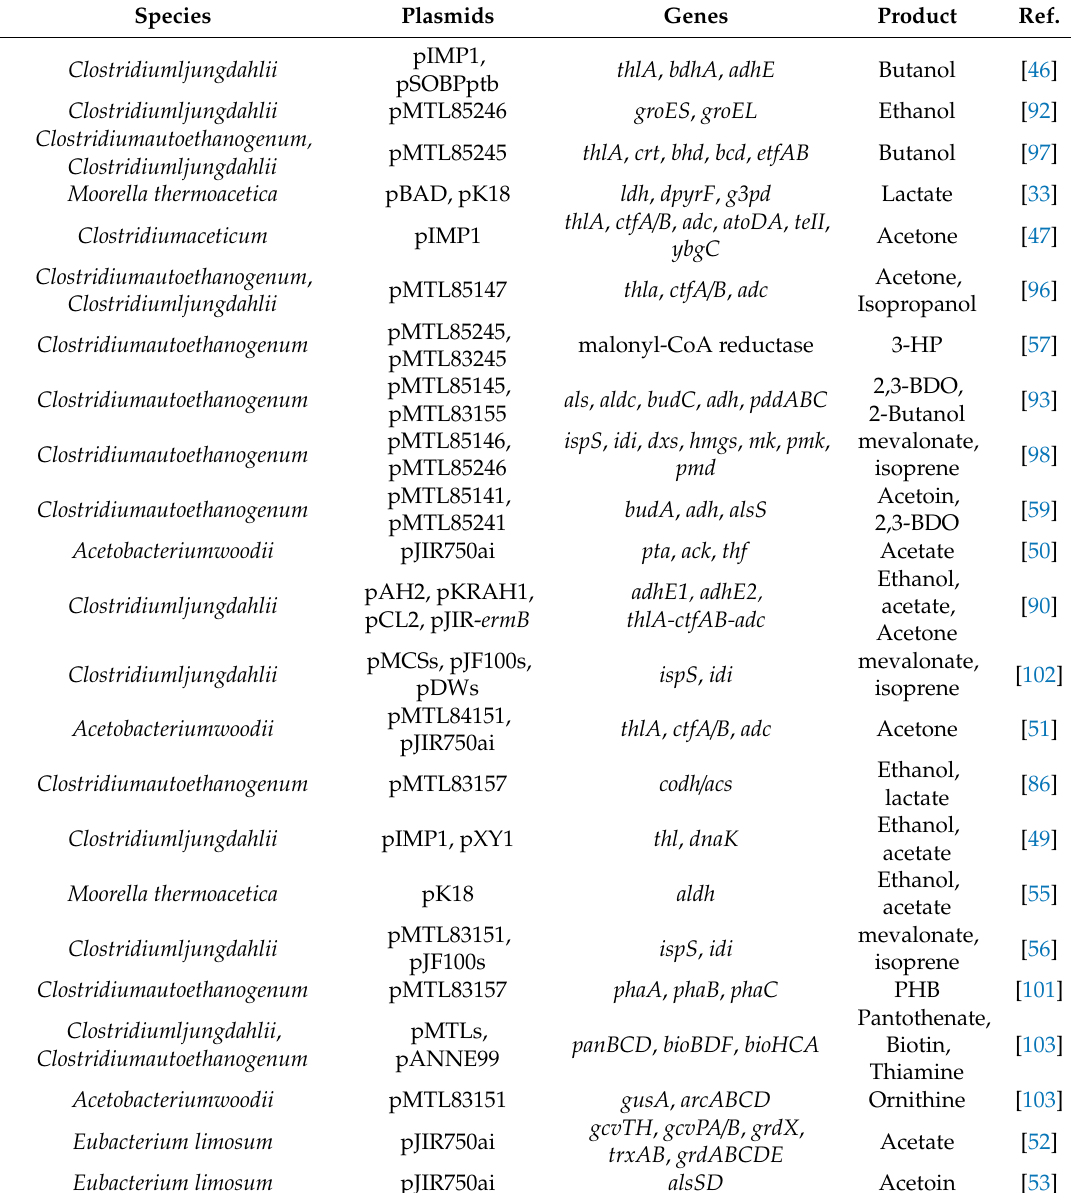
Table 3. Biochemical production using the engineered